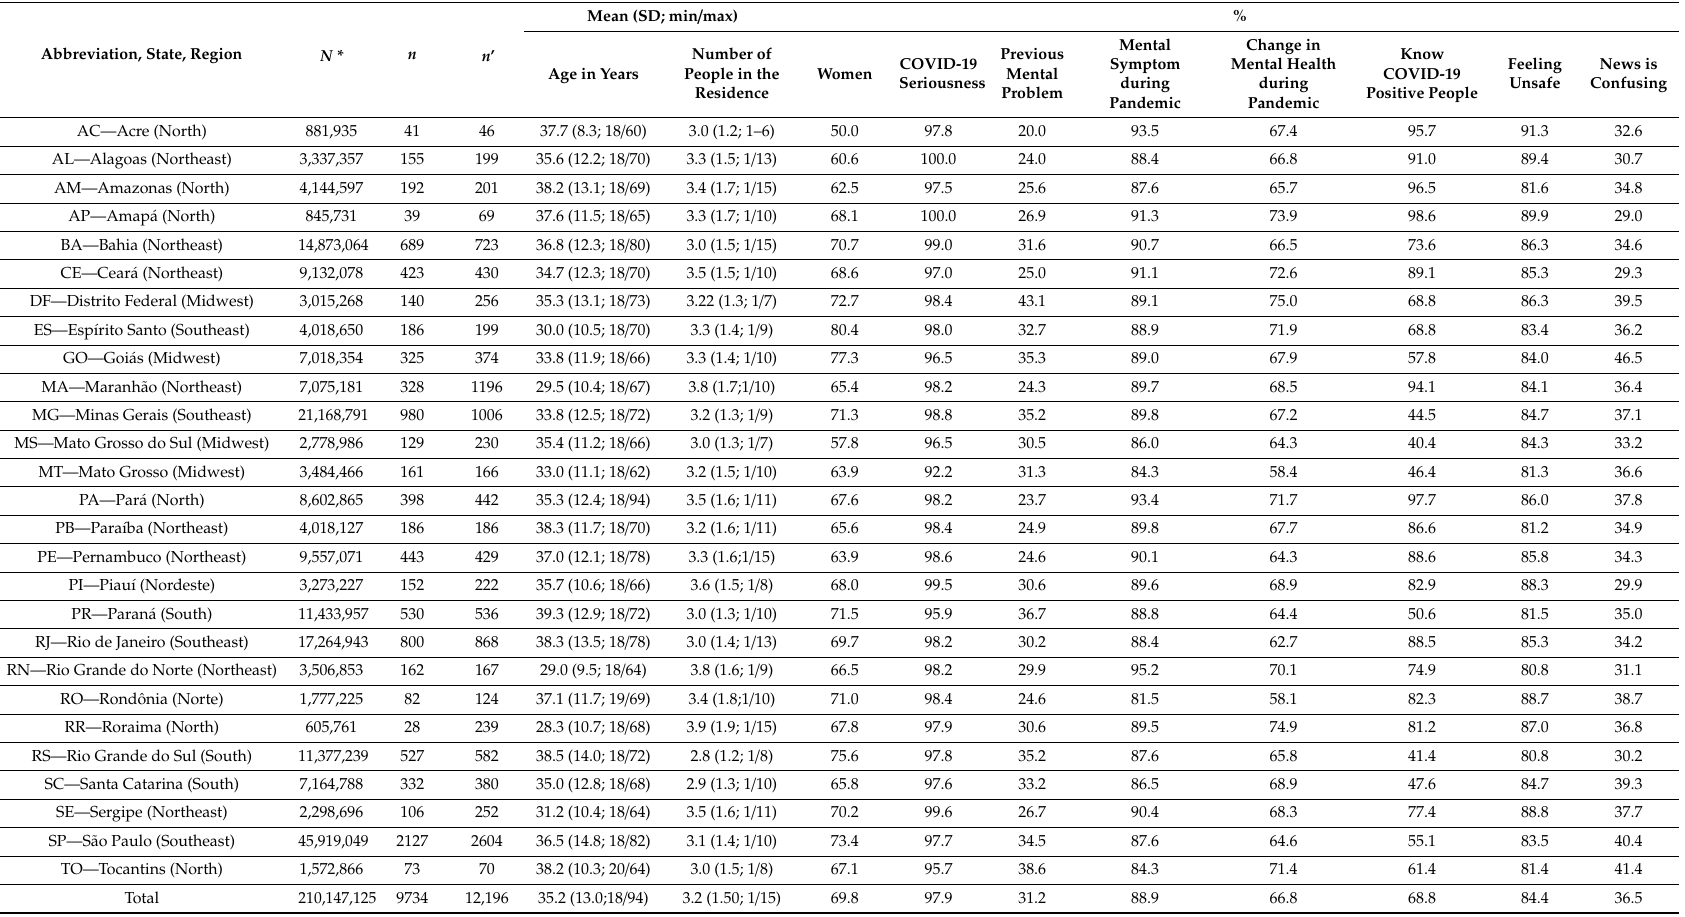
Table 2. Population ( N ) according to the State and minimum sample size estimated ( n ), final sample size ( n ’), and demographic